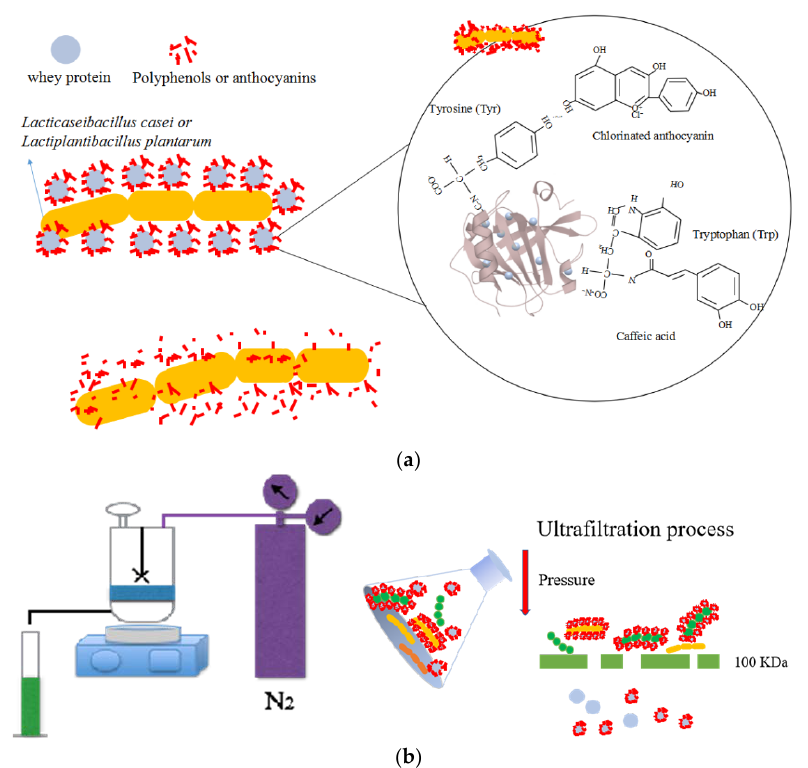
Figure 2. Schematic diagram showing whey protein and blueberry interaction with bacterial cells’ surface proteins or glycoproteins ( a ), and ultrafiltration process ( b ).